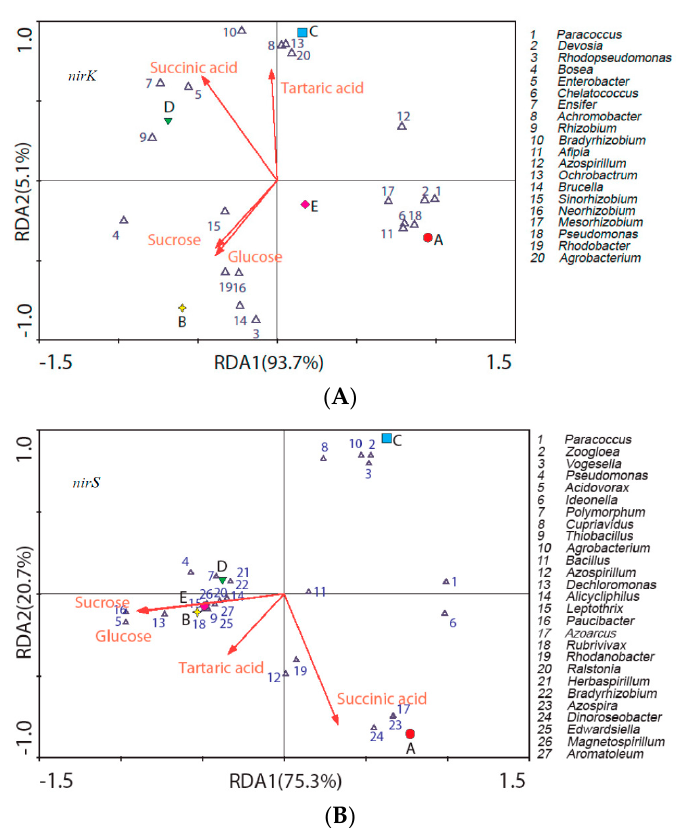
Figure 4. RDA analysis for the relationships between relative abundances of denitrifying bacteria and exudates: ( A ) RDA1 93.7% and RDA2 5.1%; ( B ) RDA1 75.3% and RDA2 20.7%. Color marks and colorless marks indicate different treatments and different denitrifying bacteria, respectively; vectors indicate the magnitude and direction of correlation between LMWC substrates and composition of denitrifying bacteria community; the angle between the microbes and vectors expresses positive and negative correlations between microbes and artificial exudates (acute angles express positive correlation; obtuse angle, negative correlation; right angles, no correlation). A = Con; B = ARE; C = Glu(–); D = Org(–); E = Ami(–).